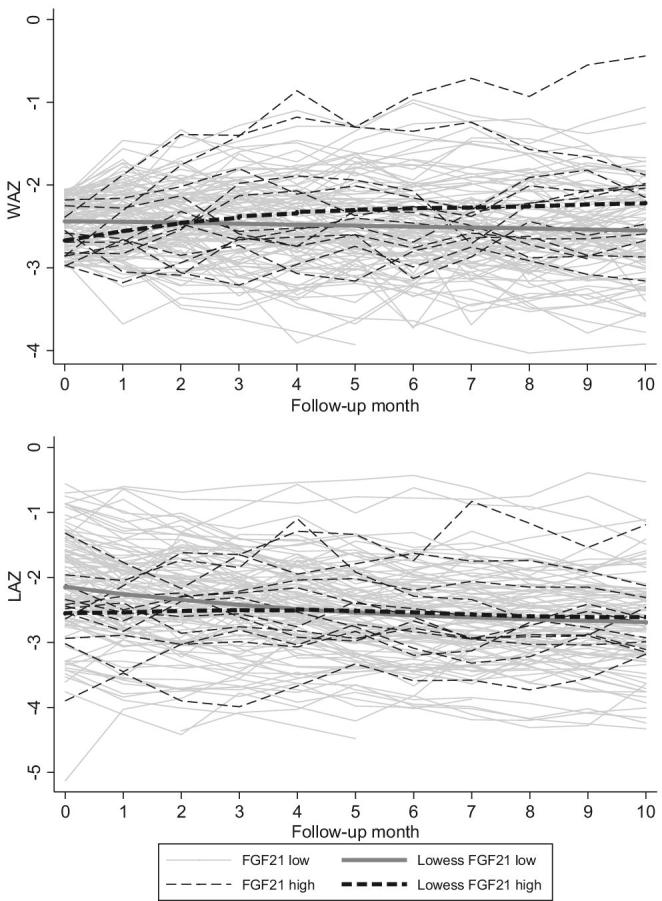
Ten-month anthropometry (WAZ and LAZ) trajectories and Lowess curves from 120 underweight children (WAZ = −3 to −2) grouped by high FGF21 (n = 12) and low FGF21 (n = 108) at enrollment. FGF21, Fibroblast Growth Factor 21; LAZ, length-for-age z score; WAZ, weight-for-age z score.